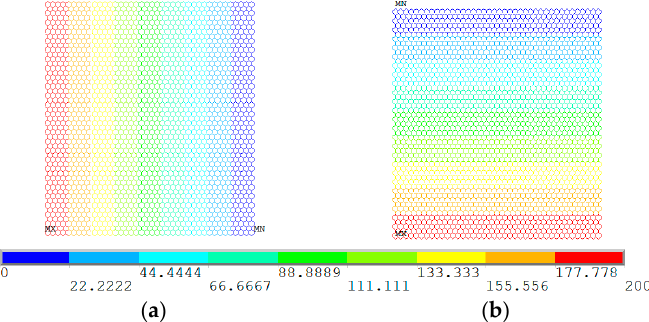
Figure 3. Finite element model of pristine graphene for the thermal conduction. ( a , b ) is its heat source in the armchair and zigzag edge, respectively.